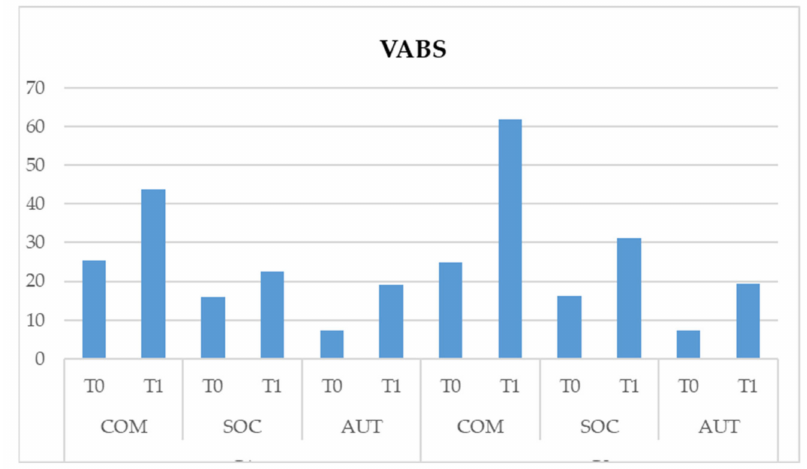
Figure 3. Effect of the scale * time * group interaction on the Vineland Adaptive Behavior Scales (VABS)